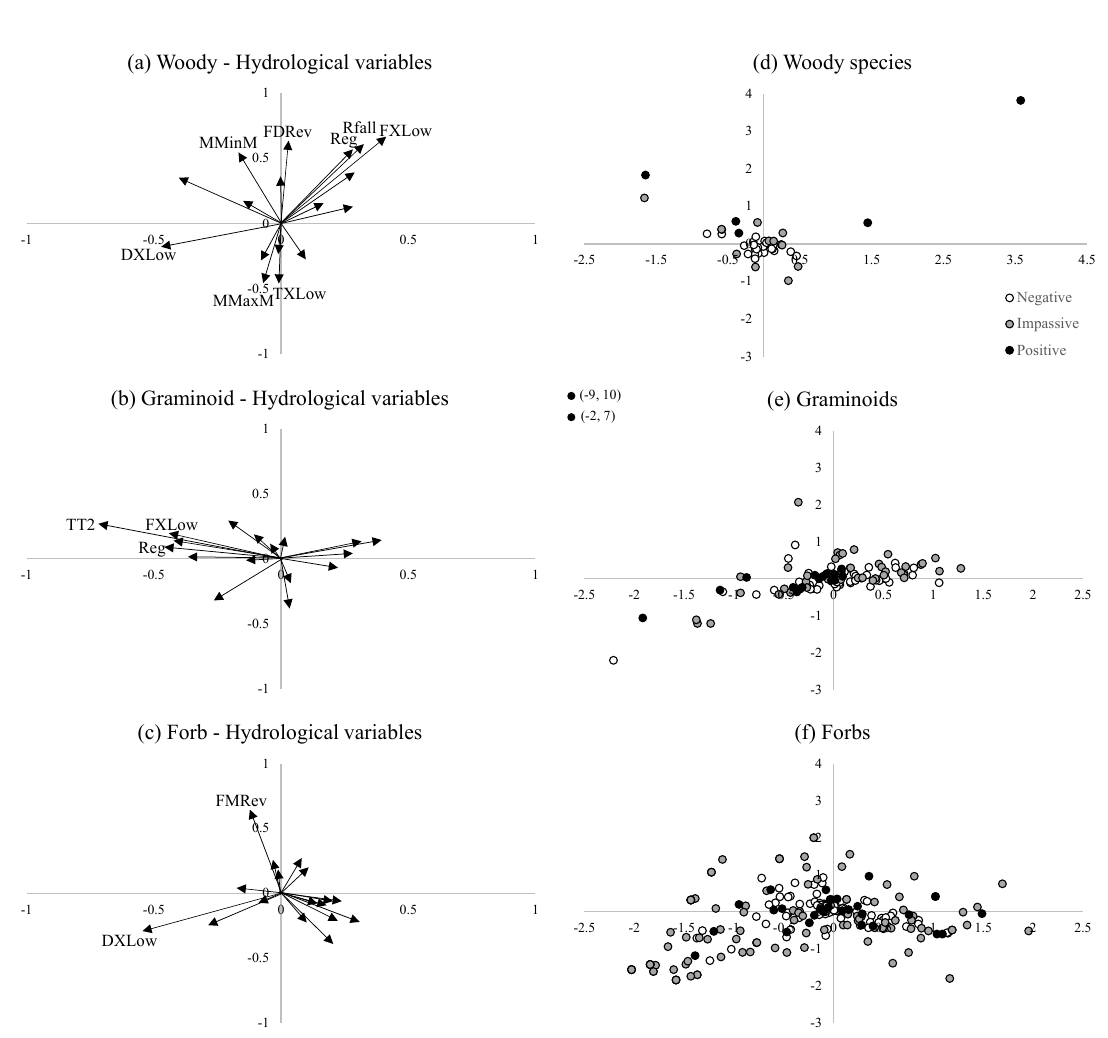
Figure 5. Biplots of the canonical correspondence analyses (CCA) on woody ( a , d ), graminoid ( b , e ), and forb ( c , f ) presence–absence species data. ( a – c) represent the canonical loadings for the hydrological variables, and ( d – f ) show species scores. For a better visualization, only hydrological variables with loadings of >0.5 are labeled. Each point is one species, with the fill color representing species response to increased flow regulation being: negative (white dots), positive (black dots), and impassive (grey dots) trends. The two dots at the top left corner in ( e ) represent two species outside the range of the x- and y-axes; their coordinates are indicated between parentheses. An explanation of the codes of the hydrological variables are in Table 1 and Annex 1.